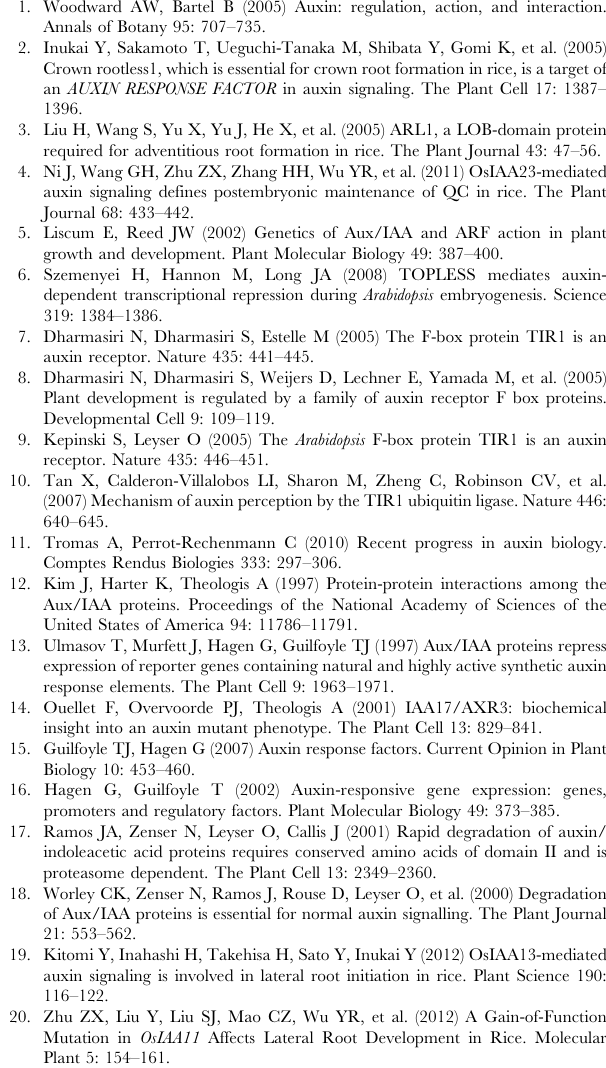
(1 cm) of 7-day-old rice. The experiment included two biological replicates (Signal 1 and Signal 2). Microarray analysis was carried out using an Affymetrix technology platform and Affymetrix GeneChip rice genome array. Table S2 The sequences of primers used in this